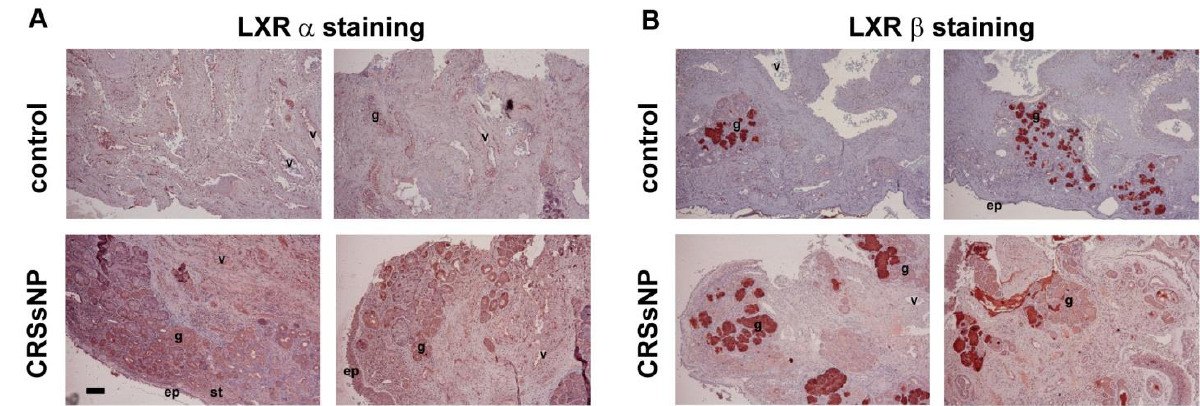
Figure 1. LXR distribution in human nasal mucosa. The ( A ) LXRα and ( B ) LXRβ distributions in respective nasal mucosae were determined by immunocytochemistry (IHC). Scale bar = 100 µ m. LXR: Liver X receptor.